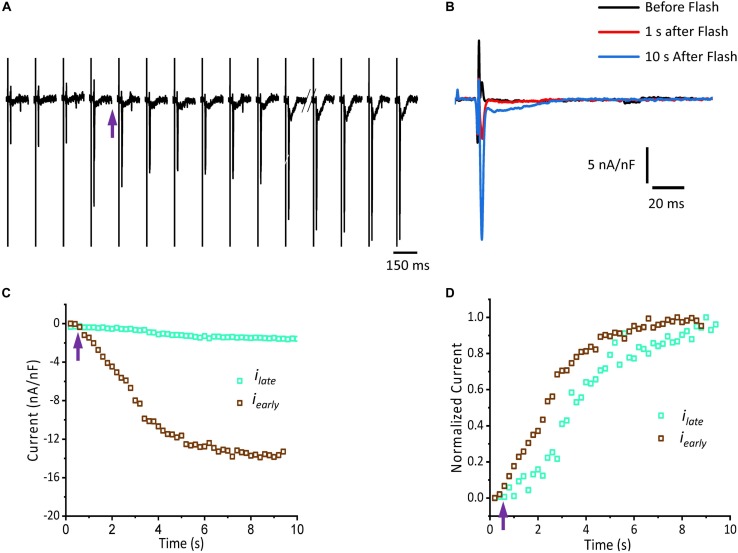
cAMP modulates the time course of Ca2+-driven currents. (A) Ionic currents recorded during consecutive cardiac cycles before and after the photolysis of caged cAMP. (B) Ionic currents induced by cAMP taken from (A) at the indicated time points (traces black, red, and blue) are overlapped to demonstrate the effect in amplitude for both iearly and ilate components. (C) Current amplitude peaks of iearly and ilate as a function of time before and after the photolysis of caged cAMP. (D) Normalized data from (C) re-plotted as a function of time. Purple arrow indicates the time of the UV pulse (cAMP uncaging).